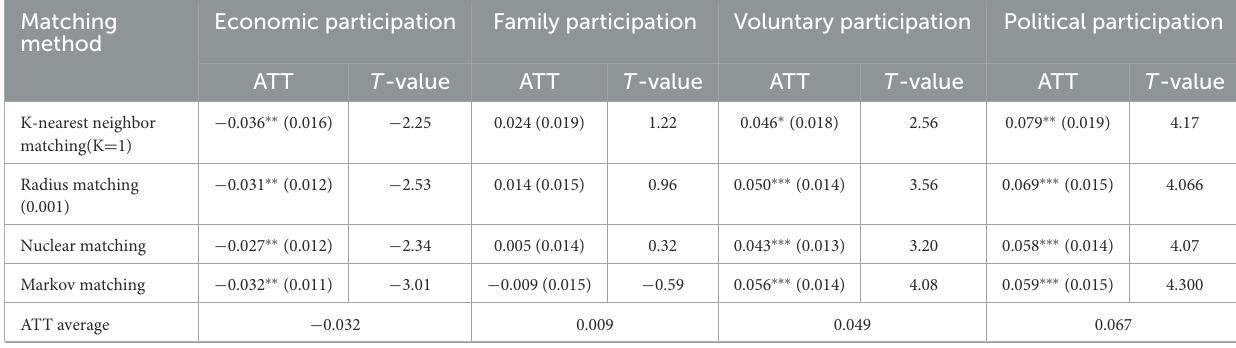
TABLE 3 Average treatment effect for the treated of different matching methods. Matching